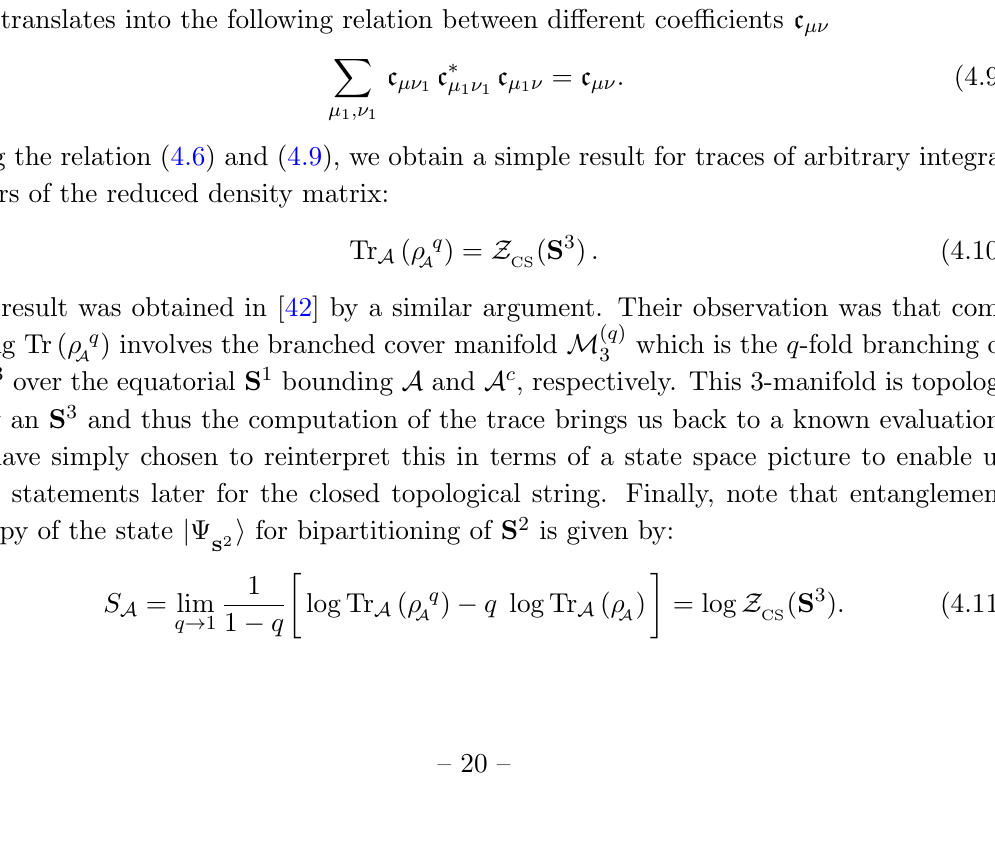
identi(cid:12)ed with A c , (cid:0) + i S 2